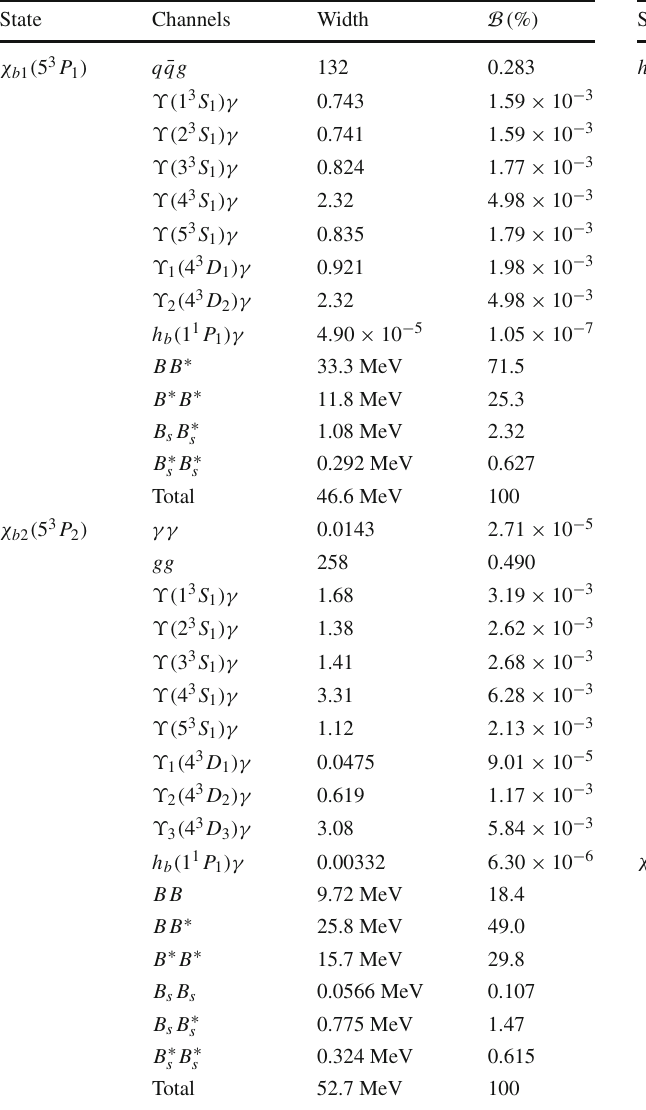
Table 24 Partial widths and branching ratios of OZI-allowed strong decay, annihilation decay, and radiative transition and the total widths for 5 3 P 1 and 5 3 P 2 bottomonium states. The width results are in units of keV